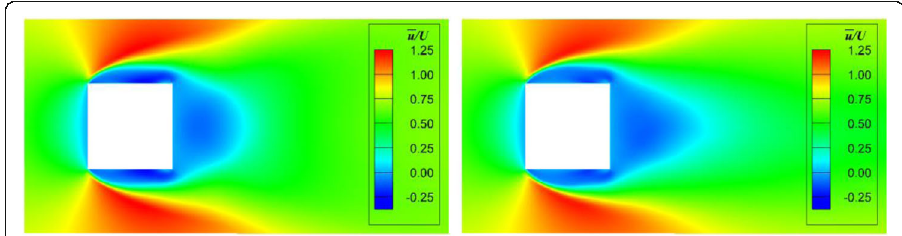
Fig. 9 Streamwise velocity contours based on 2D URANS solution (left) and 3D solution obtained by modified IDDES model